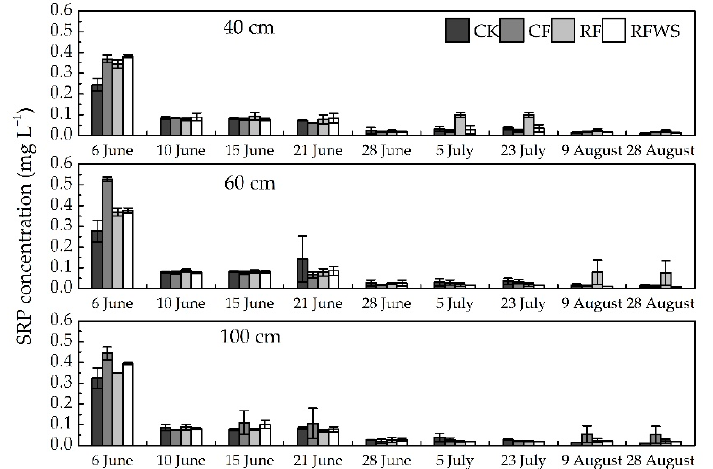
Figure 7. Changes in SRP concentration in leaching water at different depths under different fertilization treatments.